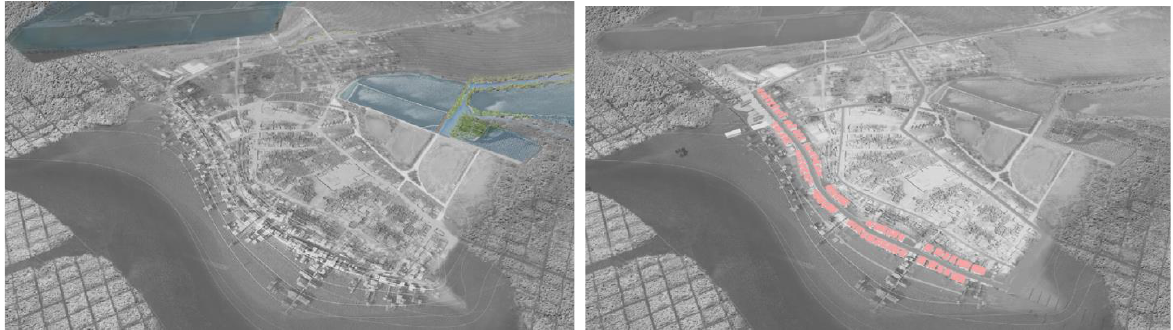
Figure 7. Informal Armature components of San José de Chamanga © Aubrey Jahelka, Shuwen Ye.